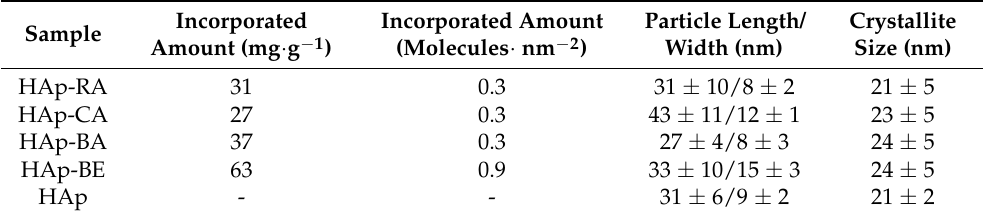
Figure 2. Synthesized HAp NP characterization. ( a ) TEM image; ( b ) X-ray diffractogram. These HAp nanoparticles were suspended in polyphenol solutions (0.5 mM) for 24 h. The number of adsorbed polyphenols was measured by TGA (Table 1 and Figure S2). BE was the most efficiently adsorbed polyphenol, with 63 mg per g of hybrid particles, loadings in RA and CA were about two times smaller and BA exhibited an intermediate value (37 mg g −1 ). When calculated as the molecular surface density, polyphenol loading was three times higher for BE than for the three other molecules. Table 1. Adsorption of polyphenols on HAp NPs. Quantity of adsorbed polyphenol on HAp measured by TGA, particle dimensions as obtained from TEM, and crystallite sizes from XRD.